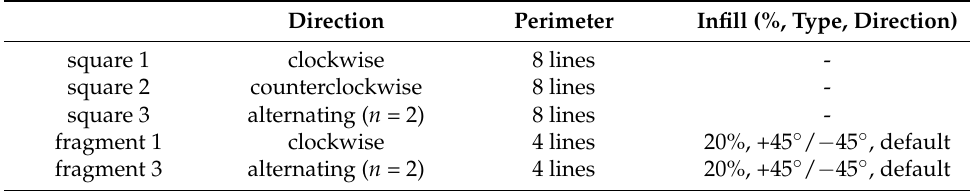
Table 3. Manufacturing properties of the